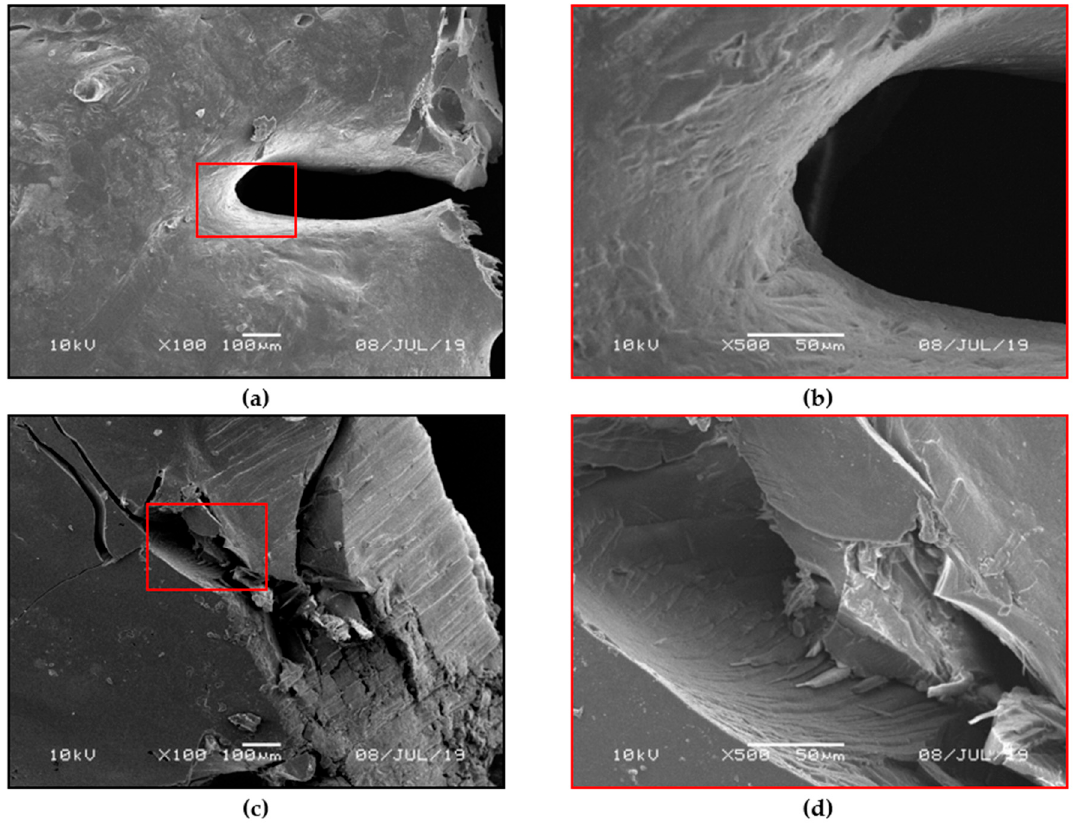
Figure 2. SEM microphotographs of residue after combustion of PET fibers modified with Cloisite ® 15A (C15A) (0.5%; 130 °C) ( a , b ). SEM microphotographs of residue after combustion of a sample of unmodified PET fibers ( c , d ).